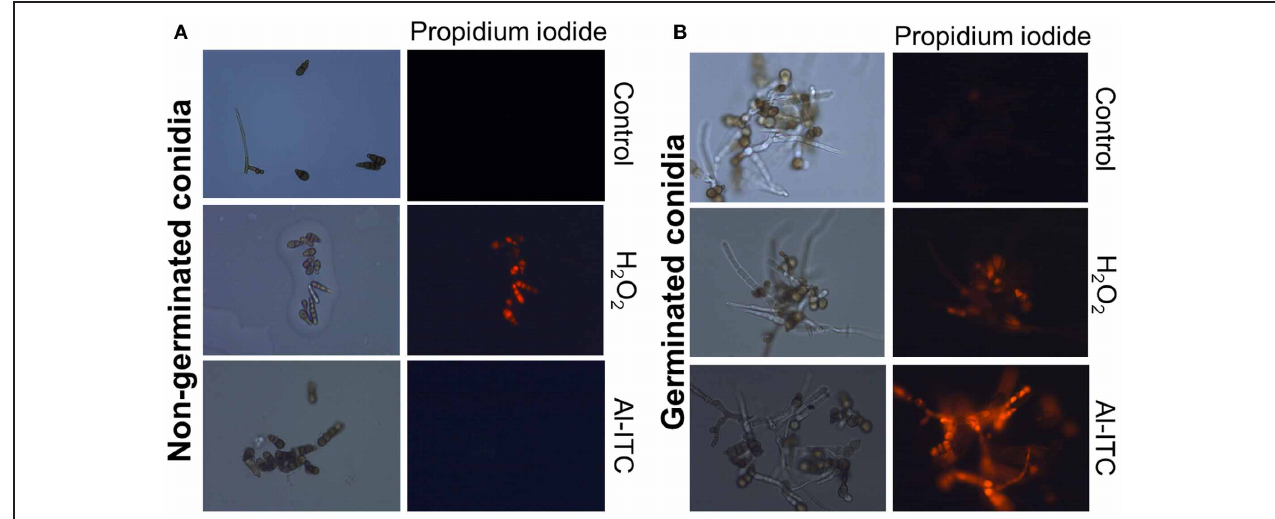
FIGURE 6 | Differential effect of H 2 O 2 or Al-ITC on the viability of the A. brassicicola wild-type strain at different physiological stages. Non-germinated conidia (A) and germinated conidia after 15h of incubation (B) were treated with H 2 O 2 (8mM) or Al-ITC (5mM) for 30min or untreated